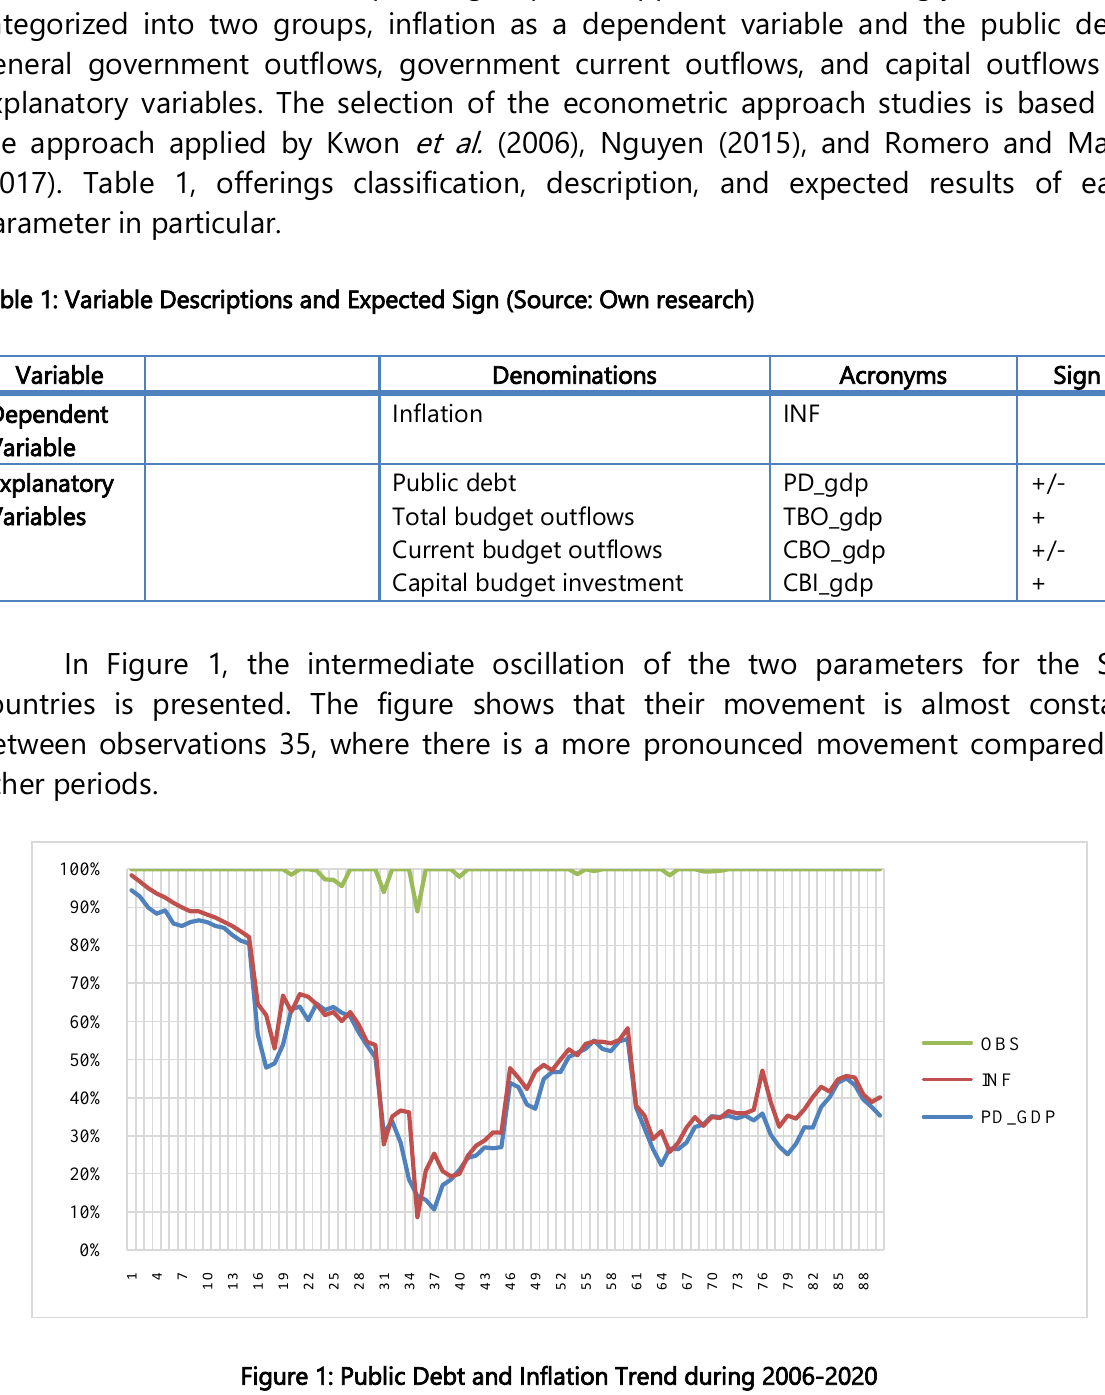
Figure 1: Public Debt and Inflation Trend during 2006-2020 (Source: World Banka Dataset and Author’s